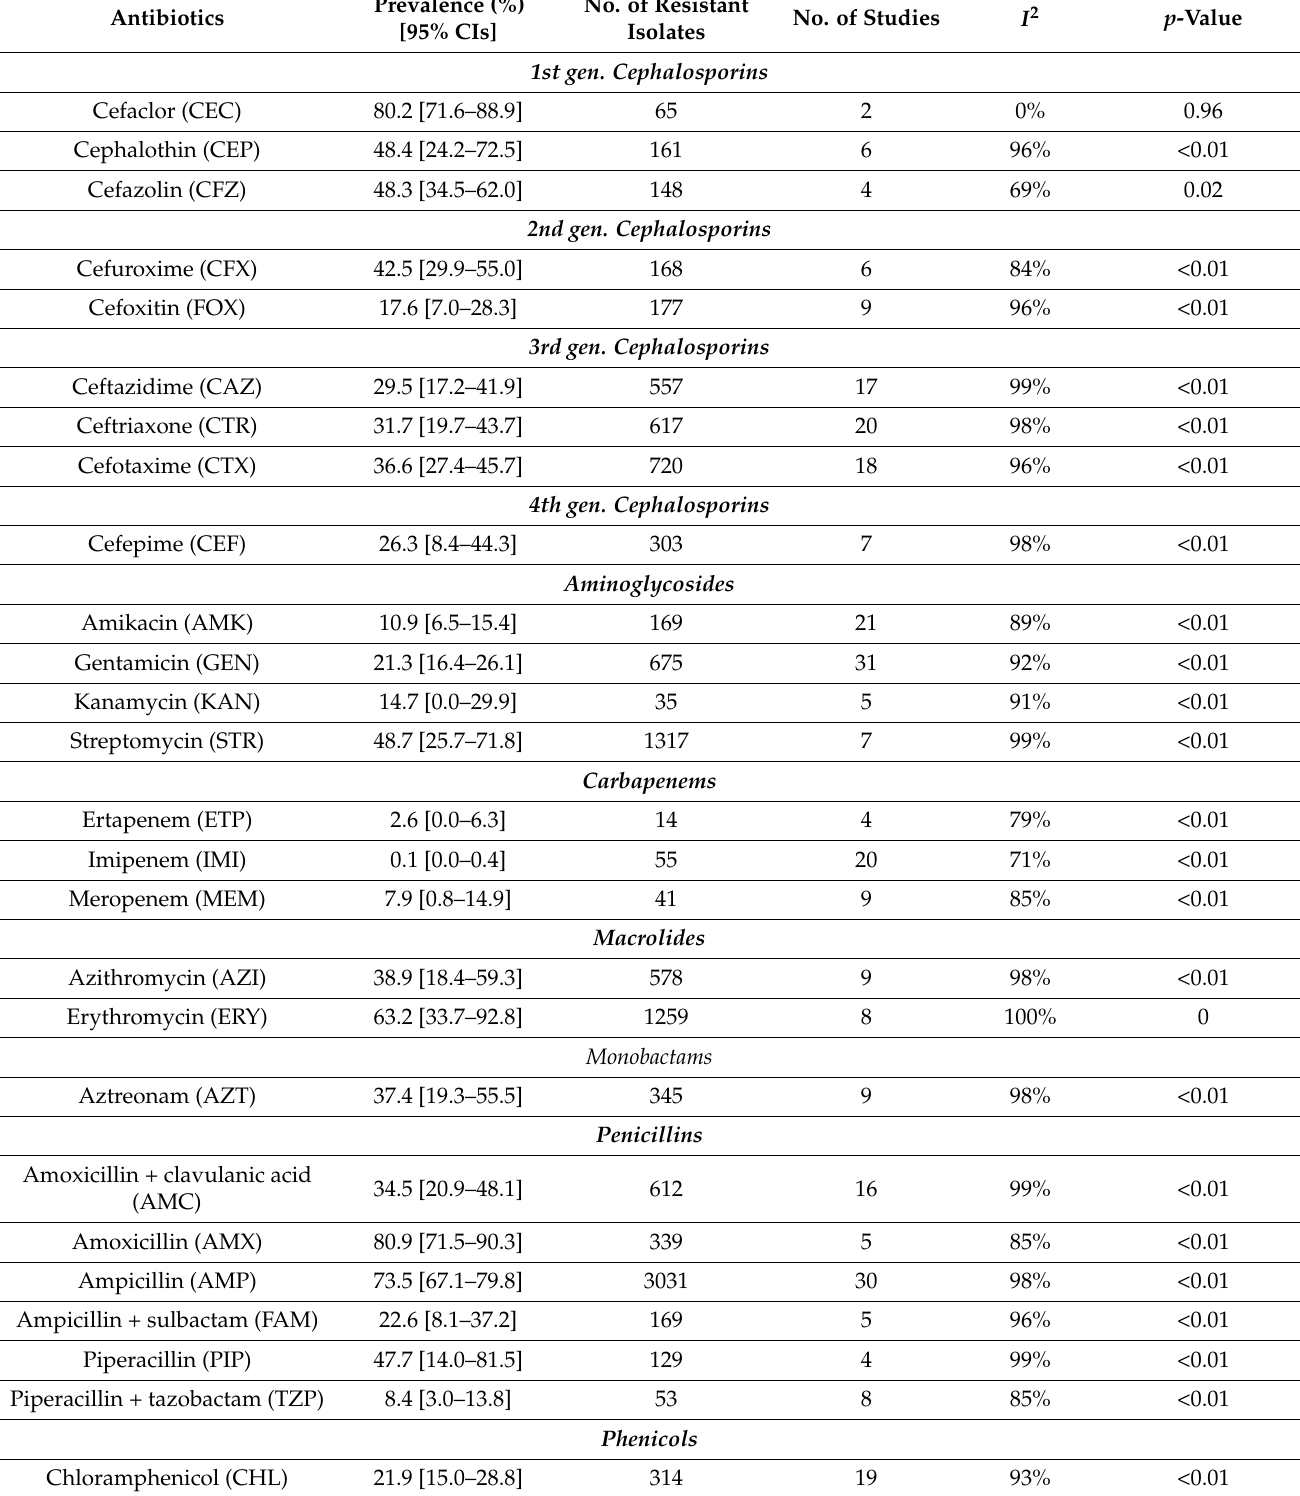
Table 3. Pooled prevalence of antimicrobial-drug-resistant DEC in